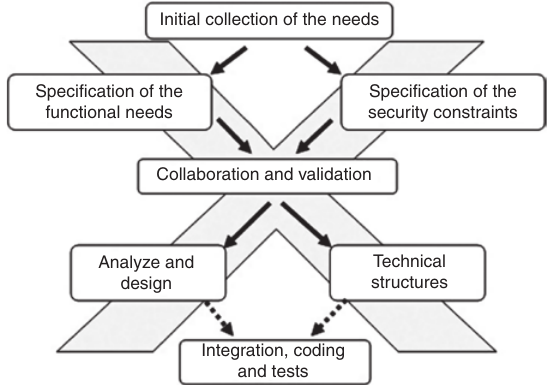
Figure 8: General Scheme of the XUP Development Method.